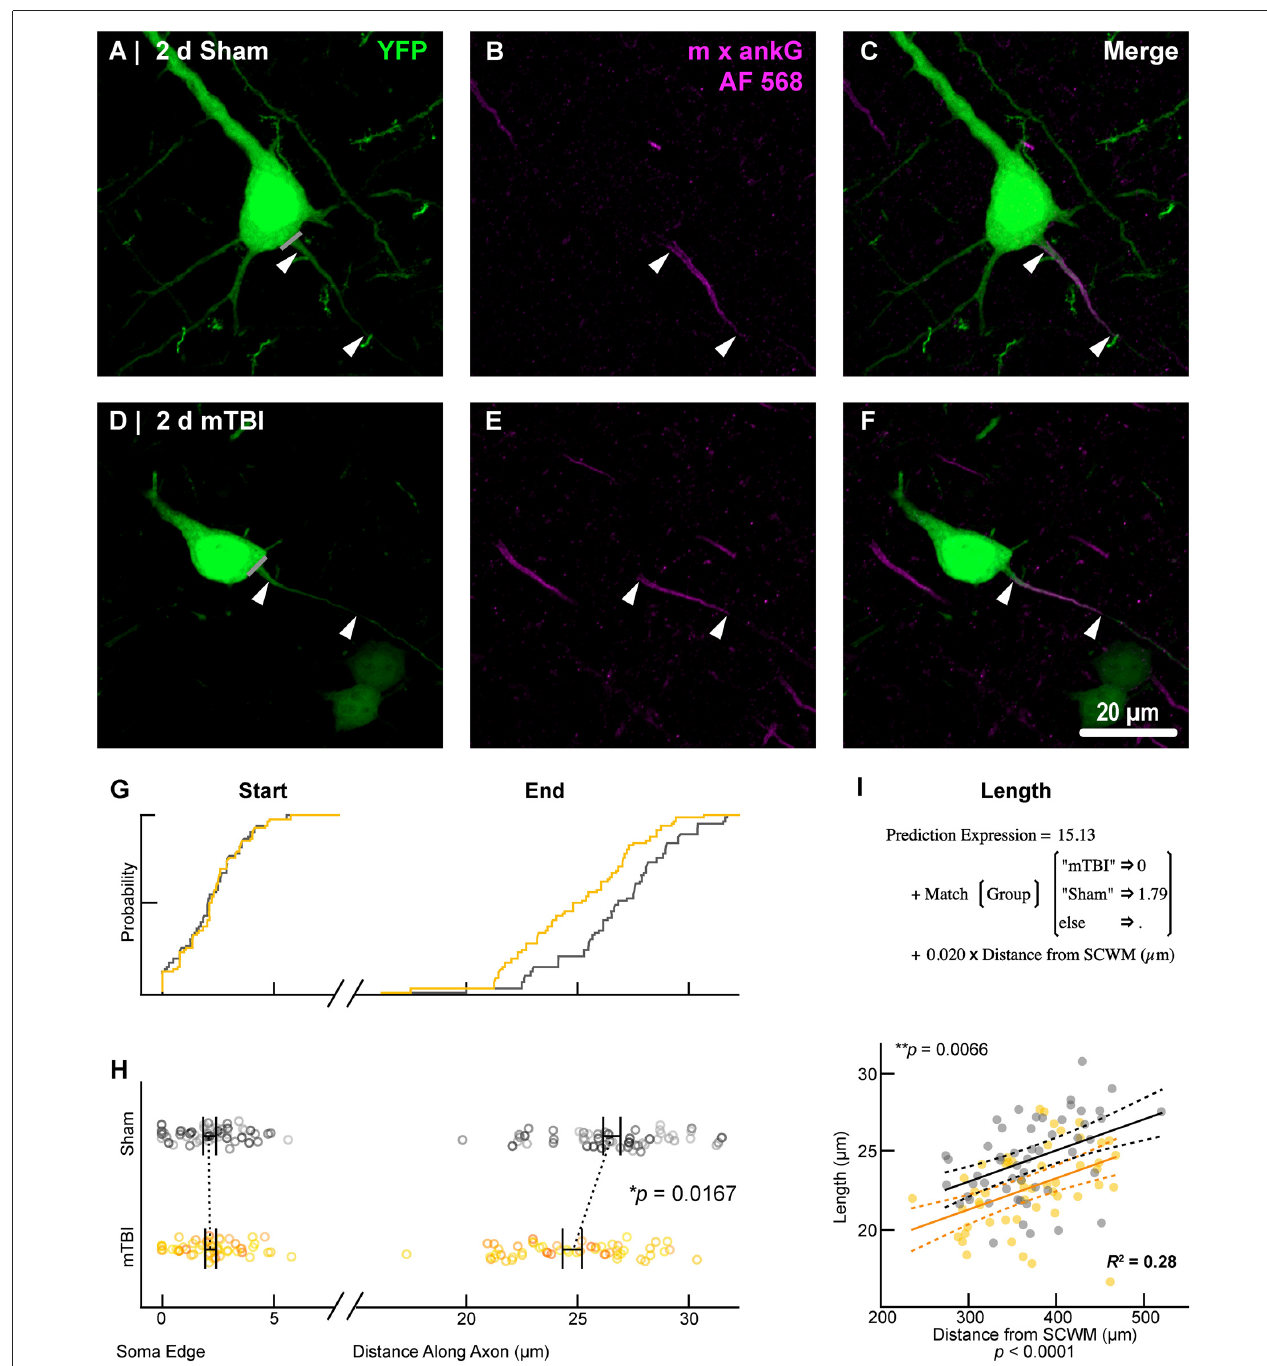
FIGURE 6 | AnkG length decreases from the distal AIS after 2 days post-mTBI. Representative images of sham (A–C) and mTBI (D–F) of YFP ( A,D ; green) and ankG ( B,E ; magenta). (C,F) Composite image showing YFP+ axon colocalization with ankG, demarcating the AIS. YFP traces were taken from the line drawn across the ado-somatic vertex (A,D) , through and past the region of the AIS (C,F) . (G–I) Quantitative analysis of ankG profiles of sham (gray) and mTBI (gold). (G) Cumulative frequency distribution plots showing overlap in start position but a proximal shift in mTBI end position. (H) Multilevel analysis of start and end positions with animals as a random variable depicted by different shades. Data summarized with means and SEM error bars. Note that there is no change in ankG start position; however, there was a significant decrease in the end position. This resulted in an overall decrease in length from the distal AIS. (I) Multilevel analysis of ankG length with animals as a random variable and distance from SCWM as a covariate. Plot of ankG length as a function of distance from SCWM (solid lines) with 95% confidence intervals (CI; dashed lines) for sham and mTBI. Note that distance from SCWM is a significant covariate of ankG length, but there is no interaction with experimental groups indicated seen as a parallel shift in